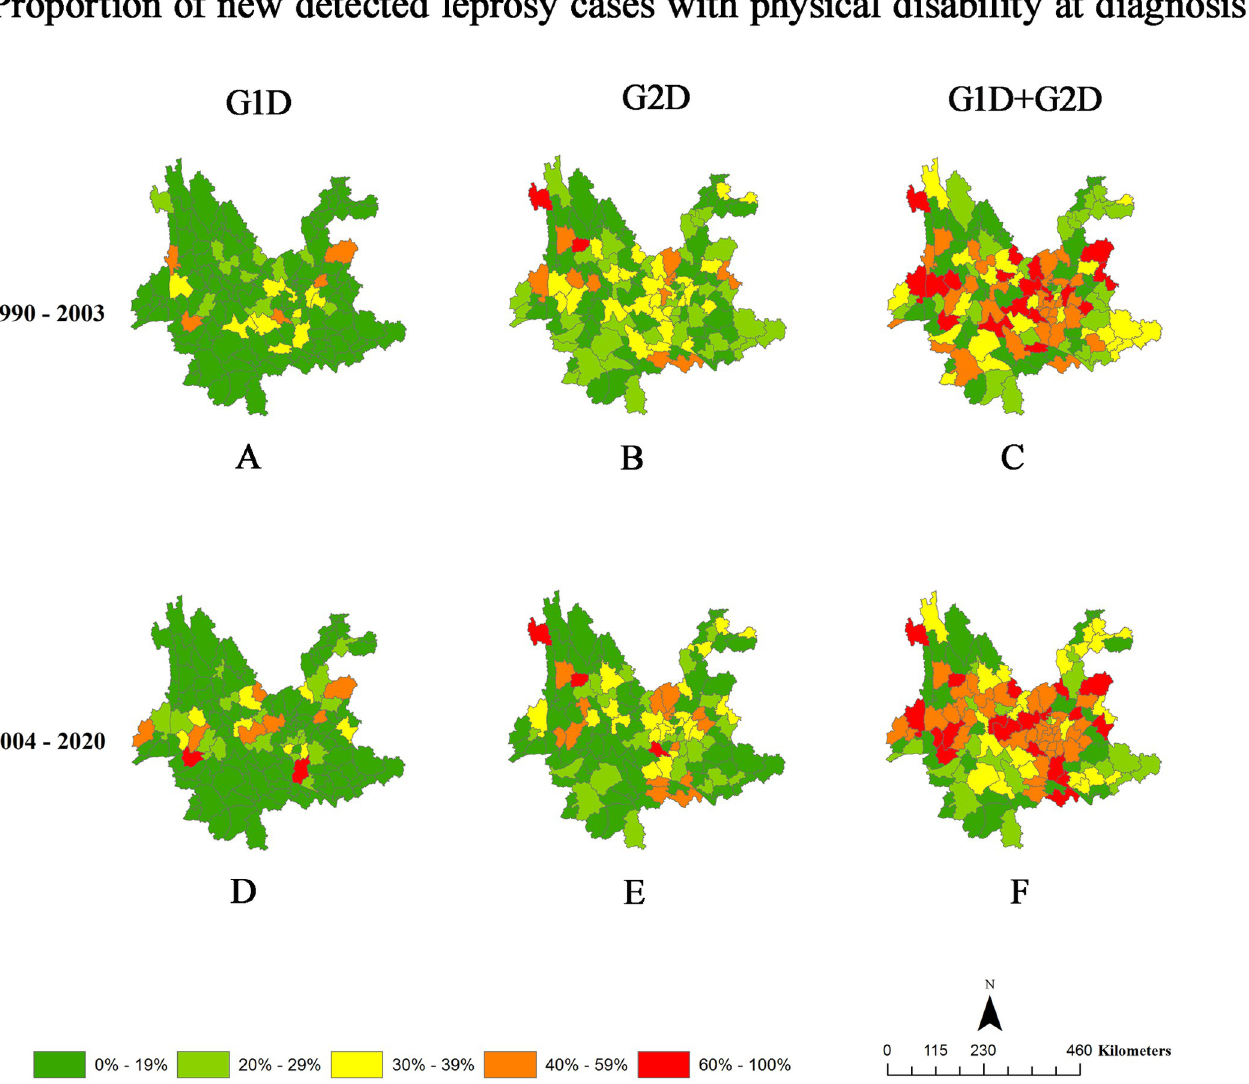
Fig 3. Detection Rates of Physical Disability Among Newly Detected Leprosy Cases in Yunnan, China, 1990–2020. The detection rates of G1D (A, D), G2D (B, E), and total physical disability (C, F) among newly detected leprosy cases in the general population in time period 1 (1990–2003) (A, B, C) and time period 2 (2004–2020) (D, E, F). Map from Naive Map developed in AMAP with data from the National Catalogue Service For Geographic Information. https://www.